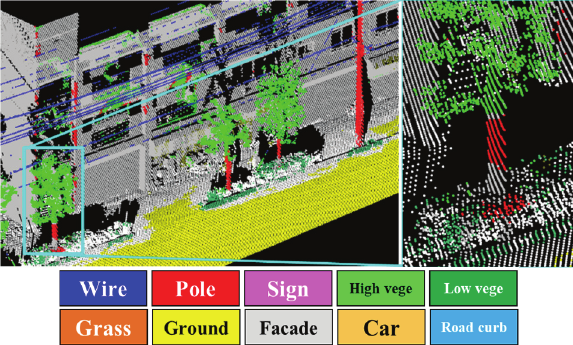
Figure 3 . Example of point clouds classification results using multi-scale